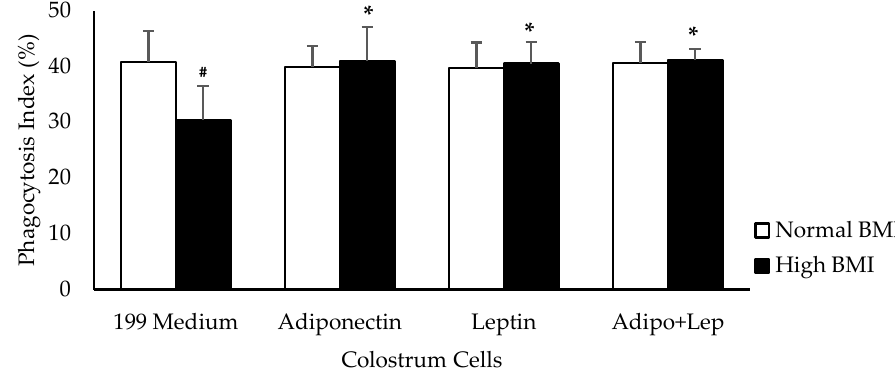
Figure 1. E ff ects of adiponectin and leptin on phagocytosis by colostrum mononuclear (MN) cells from